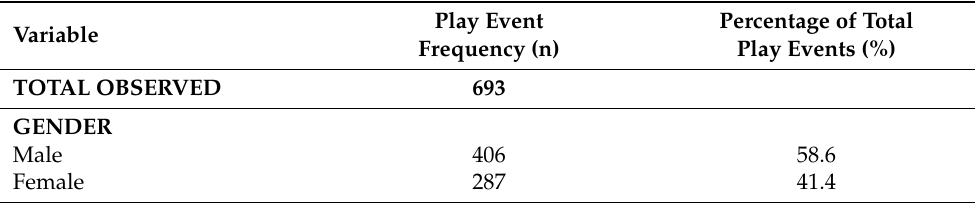
Table 1. Descriptives for all observed play